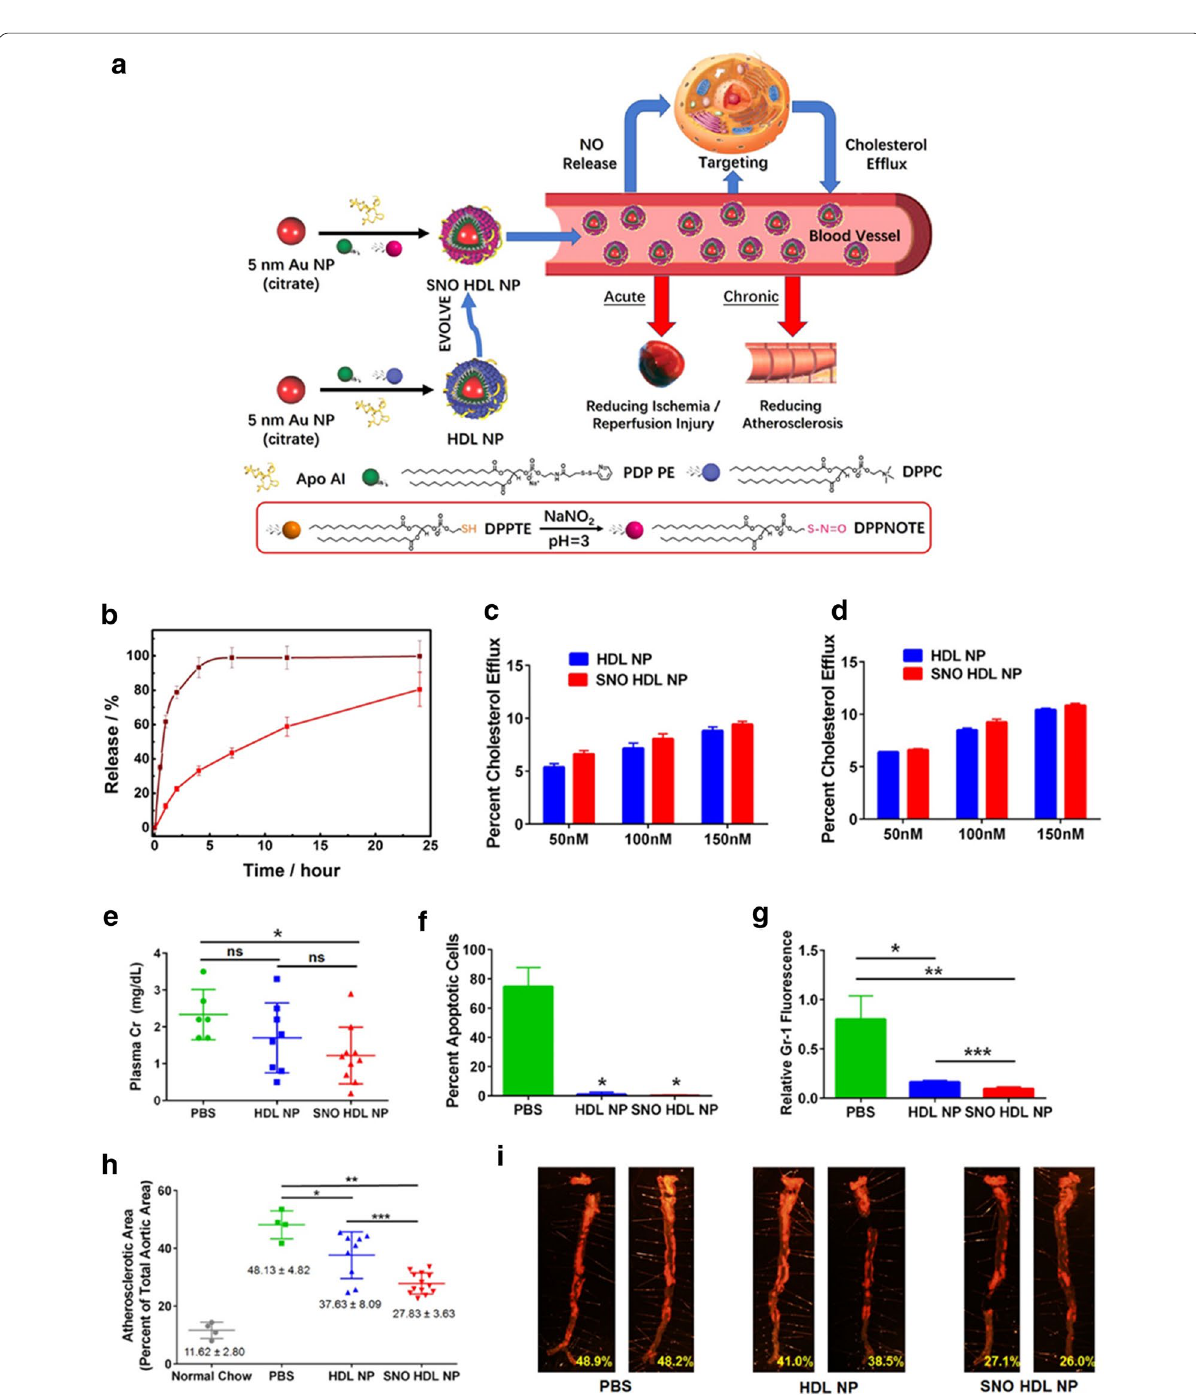
Fig. 3 a Preparation, properties, and functions of SNO‑HDL mimicking NPs. b NO release from SNO‑HDL mimicking NPs (red solid line) and DPPNOTE (brown solid line) at 37 °C. c , d Cholesterol efflux from 3H‑cholesterol loaded J774 macrophages ( c ) and differentiated THP‑1 macrophages ( d ) to SNO‑HDL mimicking NPs. e Plasma creatinine levels of mouse kidney transplant recipients on day 2 post transplantation. f Quantification of apoptosis staining in kidney transplant recipients. g Quantification of immunocytochemistry staining for Gr‑1, a neutrophil marker, in kidney transplant recipients. h Comparison of atherosclerotic area of ApoE − / − mice fed with a high‑fat diet (HFD) for 12 weeks, then administered with PBS, HDL mimicking NPs, or SNO‑HDL mimicking NPs for an additional 6 weeks. i Representative images of aortas from mice treated with PBS, HDL mimicking NPs, or SNO‑HDL mimicking NPs. Red fluorescent staining indicates atherosclerotic plaques. Reproduce with permission